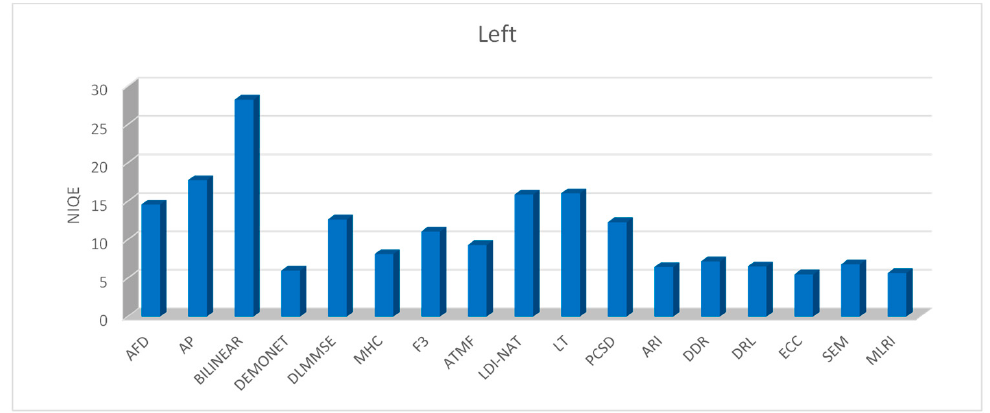
Figure 5. Averaged NIQE scores of R, G, and B bands for left images using all methods.